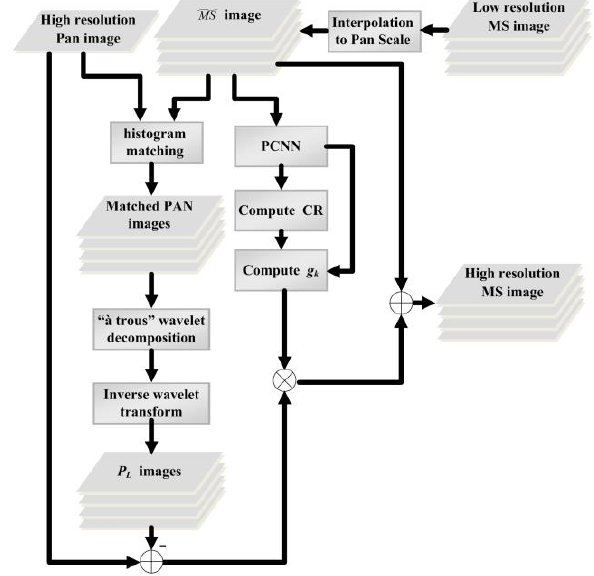
Figure 1. The architecture of the proposed PSBP method